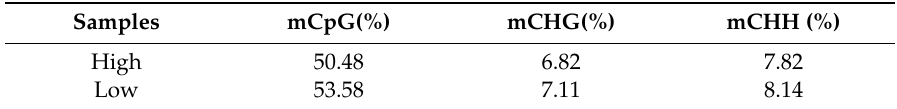
Table 3. Genome-wide methylation levels of the two high- and low-cortisol groups for CpG and non-CpG sites.